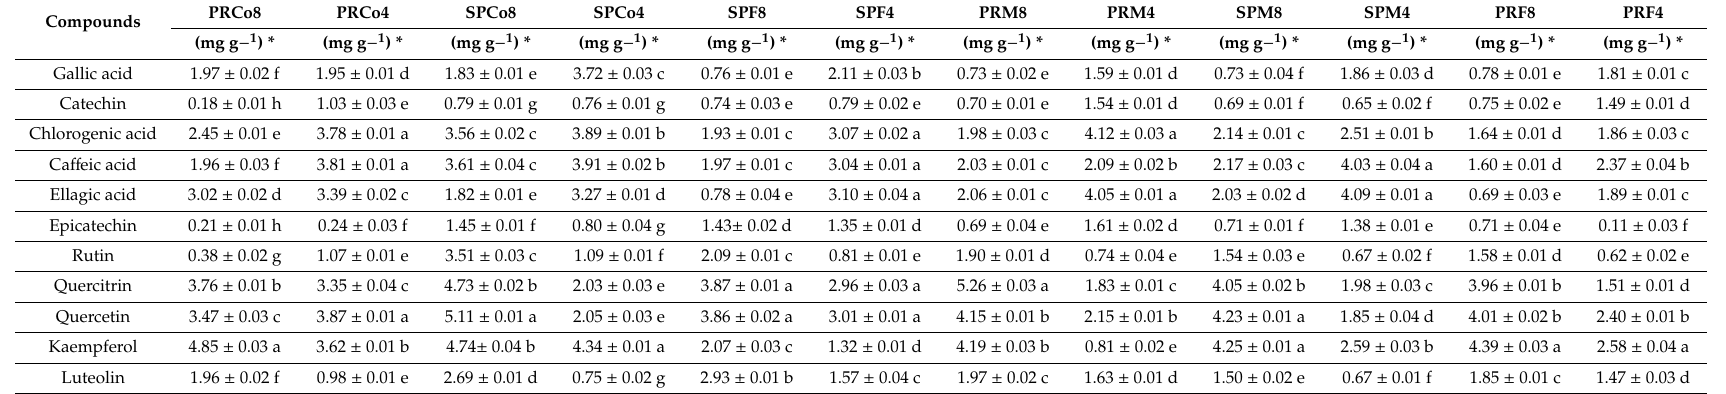
Table 3. Concentrations of polyphenols of B. myriocephala and B. trimera